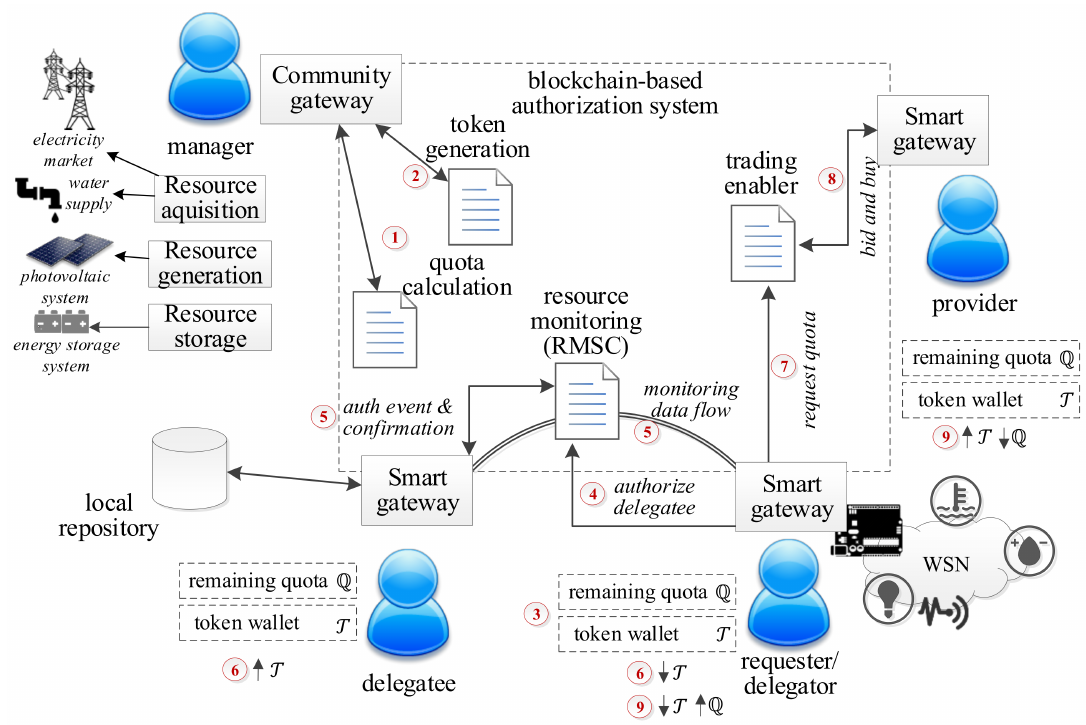
Figure 1. Architecture of the blockchain-based authorization